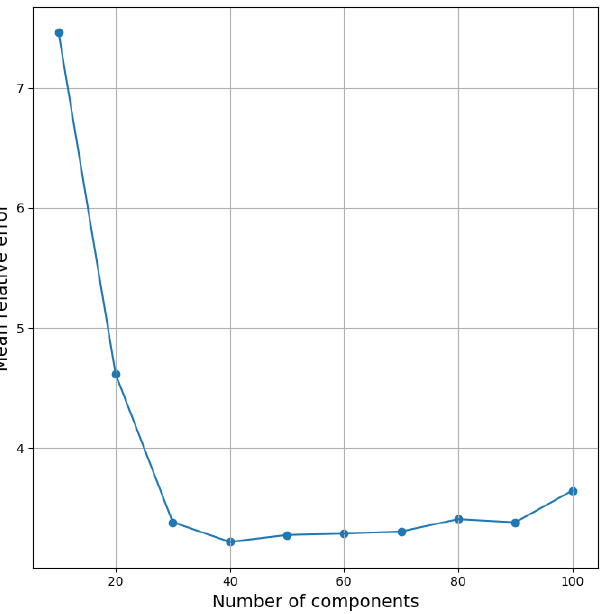
Figure 4. Dependence of the mean relative error averaged over three runs on the number of princi- pal